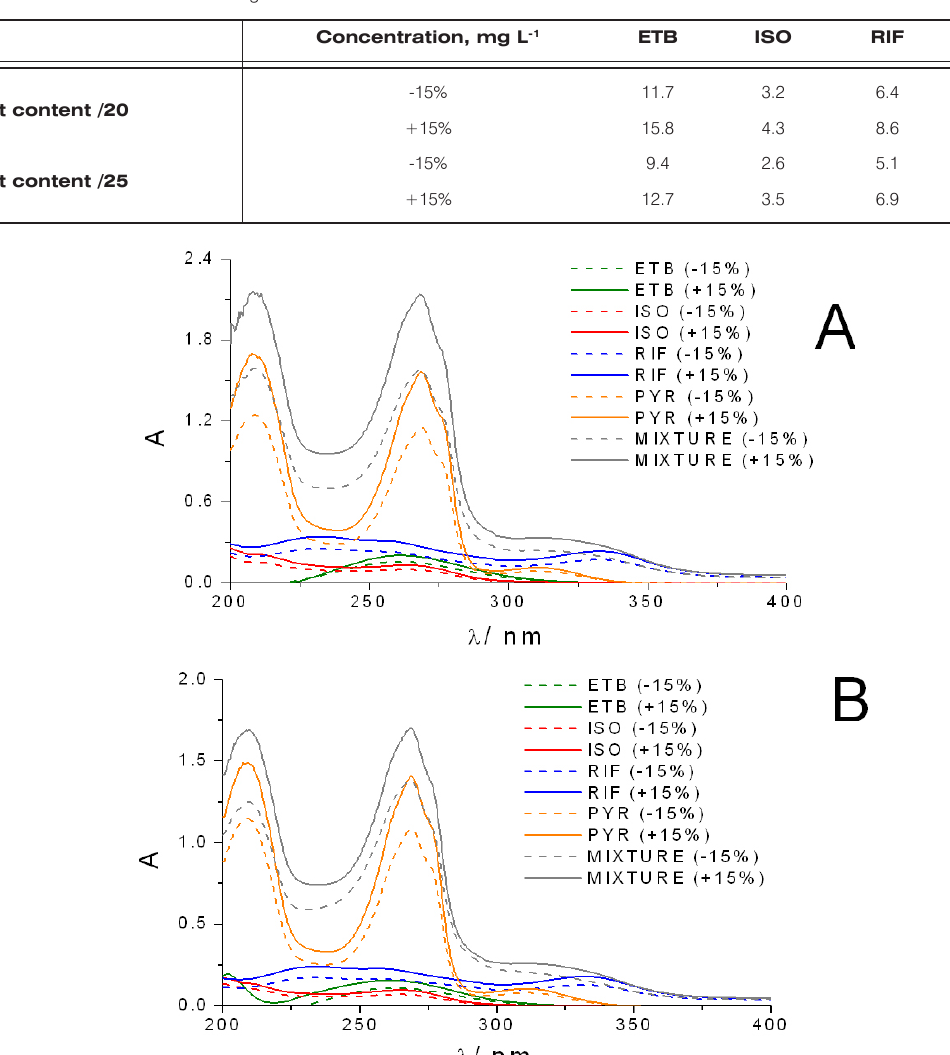
Table 1. Concentration variation range of the standard mixtures solution.